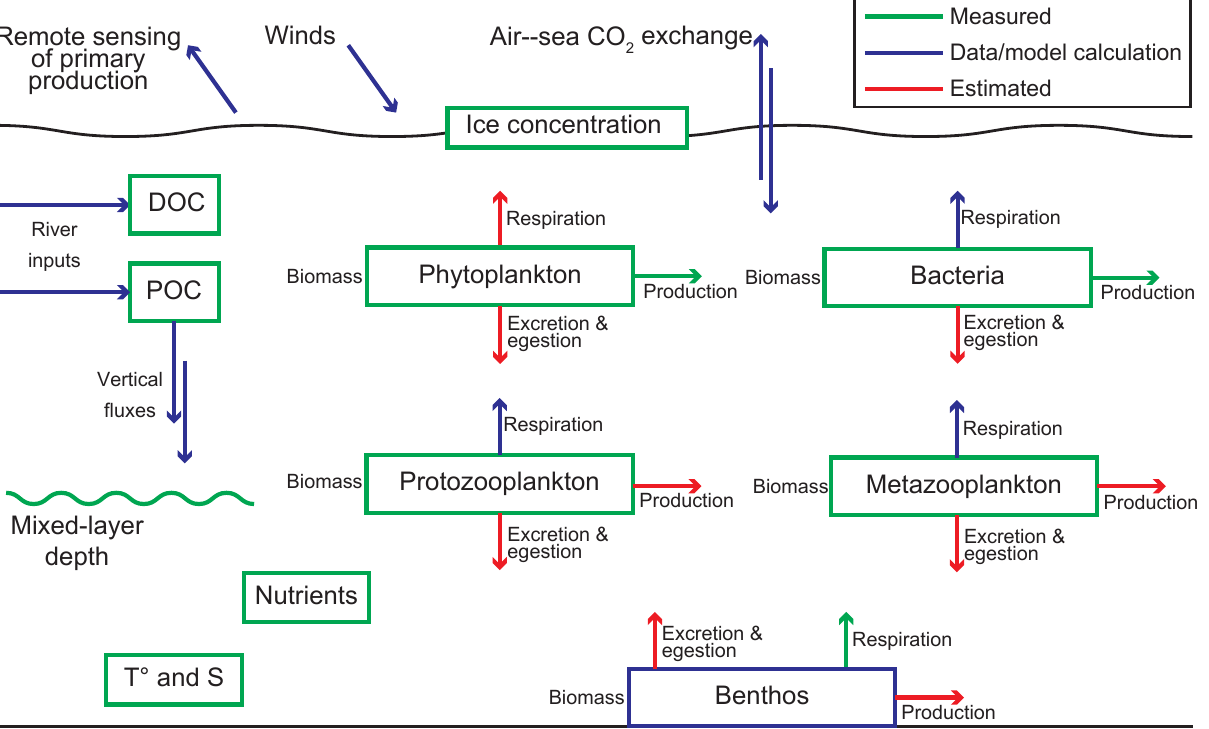
Figure 2. Diagram showing which variables have been directly measured on the field during ArcticNet–Malina, versus which ones have been calculated using a combination of in situ data and statistical models, or rather estimated using knowledge from the literature or deduced from previous regional studies. This schematic aims at facilitating the reading of the methodological Sects. 2.2–2.6. The biophysical context at a regional scale prior and during the field campaign was documented using sea ice, wind and ocean color PP estimates gathered from different sources. For a detailed description of equations linking metabolic pathways of the planktonic and benthic compartments, please see Appendix B in Forest et al.